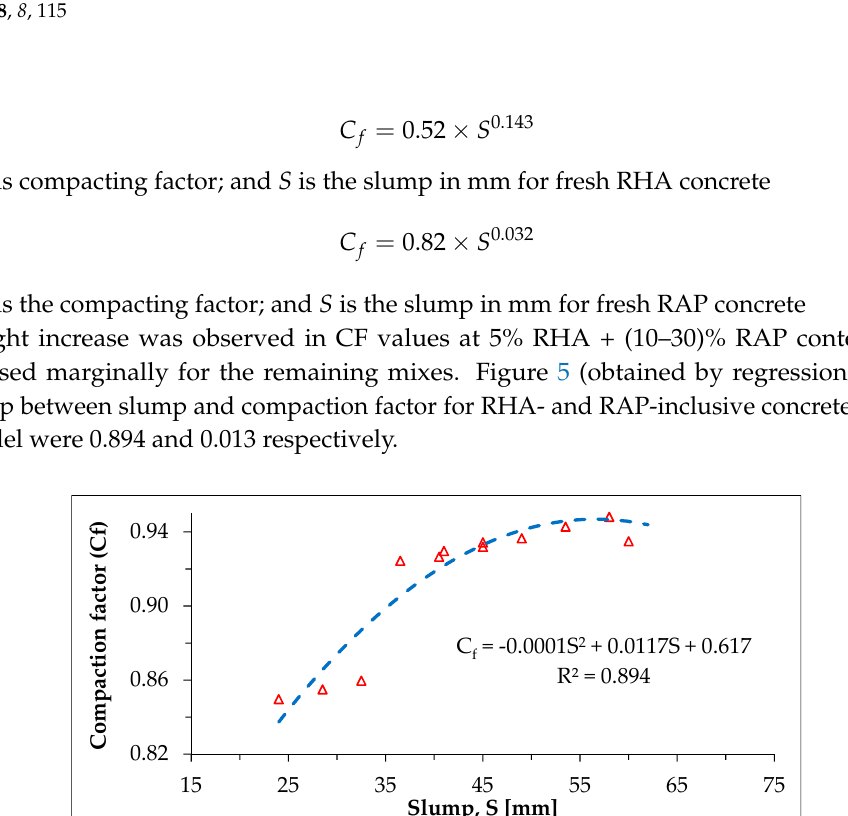
Figure 6. Fresh density for RHA and RAP concrete.